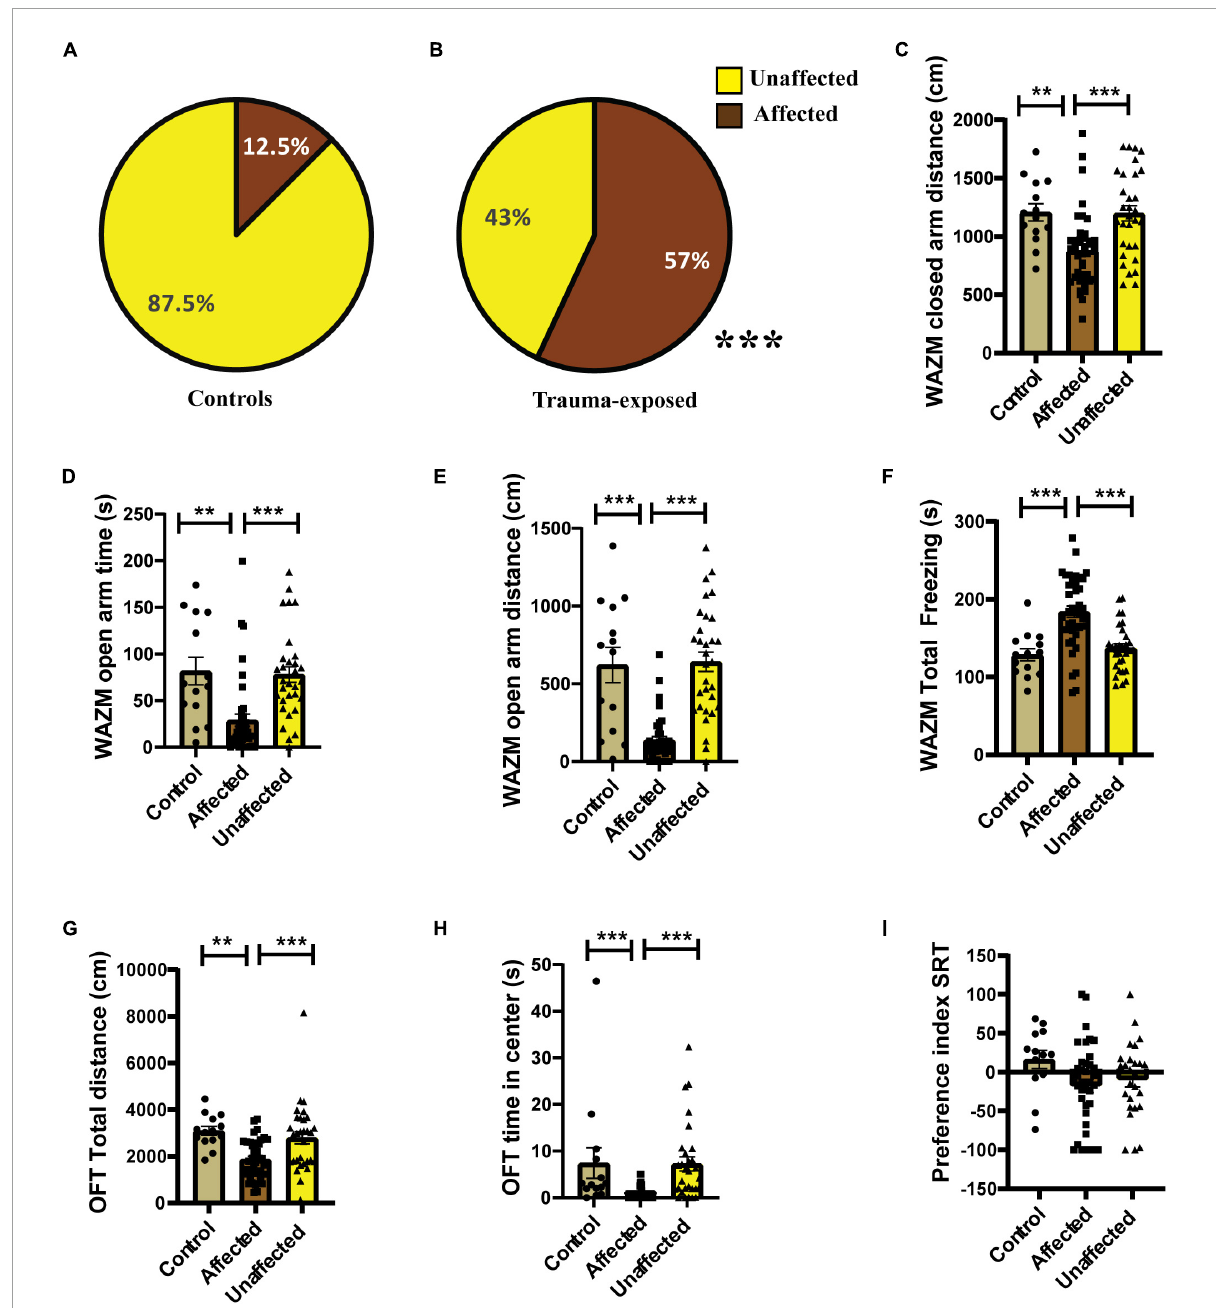
FIGURE6 Individual behavioral profiling-2 (IBP2) classified animals into affected or unaffected in different groups. (A) Percentage distribution of affected animals and unaffected animals in control group. (B) Percentage of affected animals was found to be significantly higher in trauma-exposed animals than controls at 2 weeks post UWT [(Fisher exact test, p *** < 0.001); Control ( n = 16), trauma-exposed ( n = 72)]. (C) Distance traveled in the closed arms of WAZM was least in the trauma affected animals [Kruskal–Wallis test H (3) = 18.25, ( p = 0.0001); Dunn’s post-hoc test p ** < 0.01, p *** < 0.0001]. (D) Time spent in the open arms of WAZM was less by the trauma affected animals than controls and trauma un affected animals [Kruskal–Wallis test H (3) = 27.03, ( p < 0.0001); Dunn’s post-hoc test p ** < 0.01, p *** < 0.0001]. (E) Distance traveled in